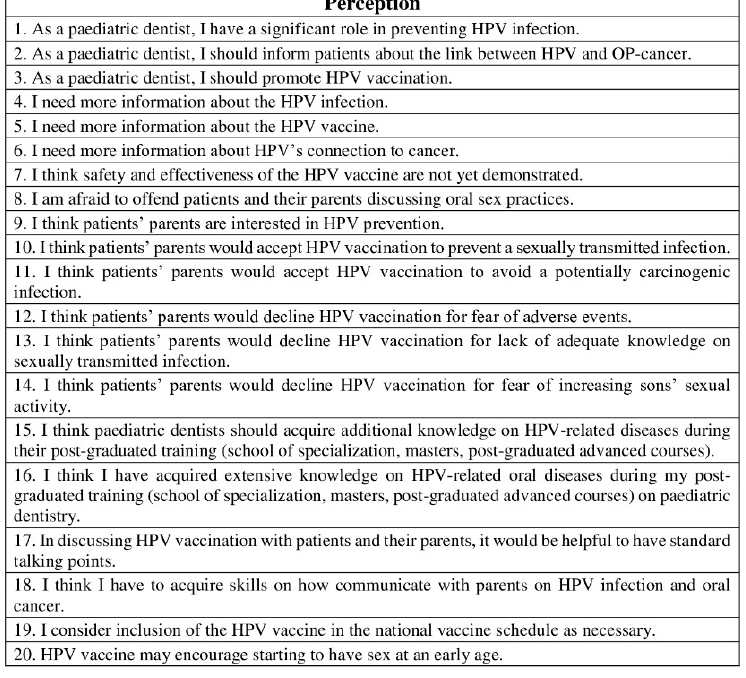
Figure 5. Questionnaire assessing pediatric dentists’ attitude on HPV-related OP-cancer, HPV infection, and HPV vaccine. Level of agreement to each statement was assessed by a five-point Likert scale: 1. strongly disagree; 2. disagree; 3. neither agree nor disagree; 4. agree; 5. strongly agree.